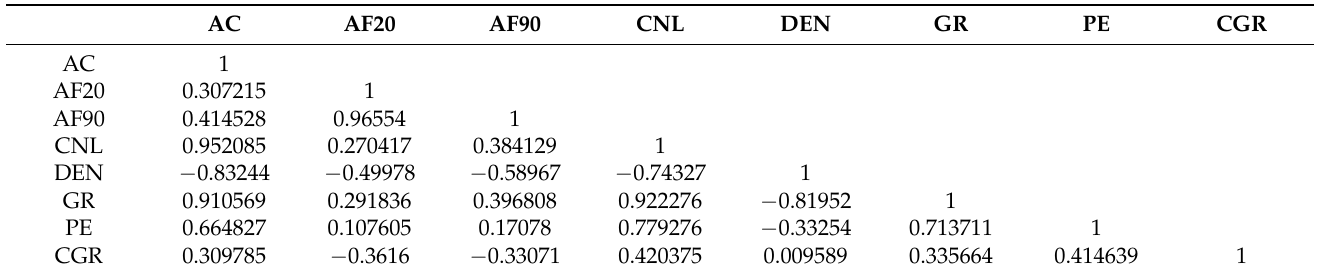
Table 3. Correlation analysis of logging curves in interval c in the study